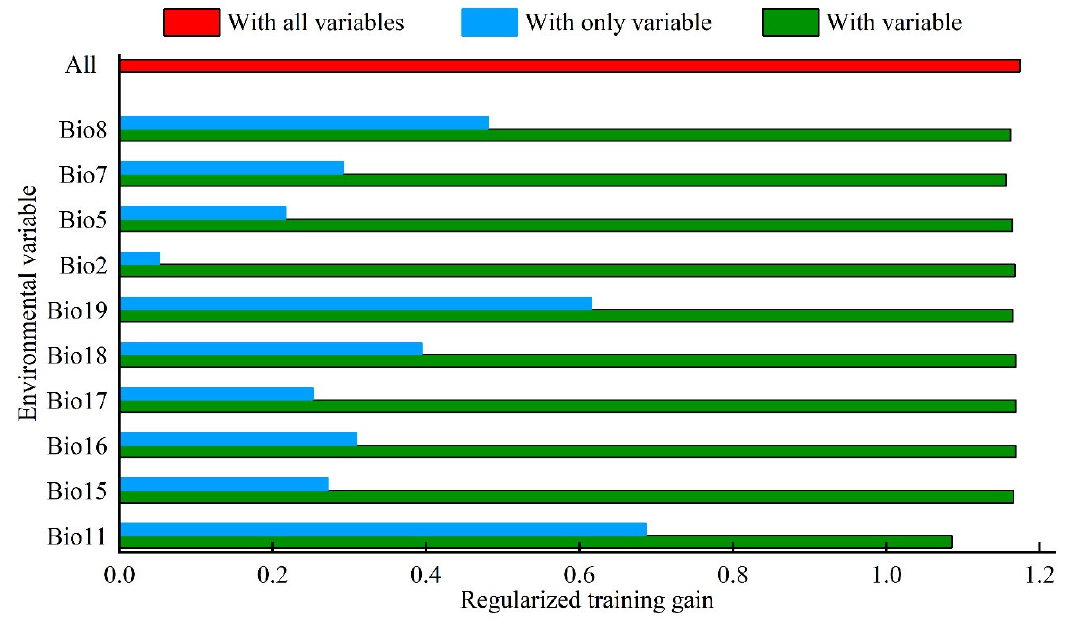
Figure 4. Jackknife test results for Linepithema humile bioclimatic variables.